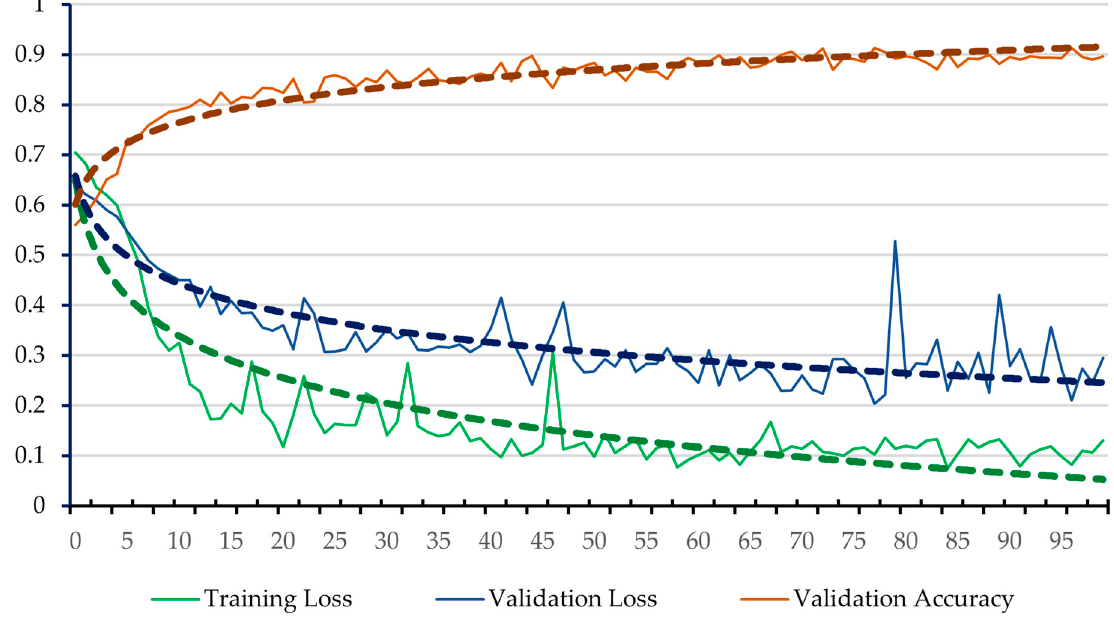
Figure 8. PointCNN train loss (green line), validation loss (blue line), and validation accuracy (orange line) for training parameters.